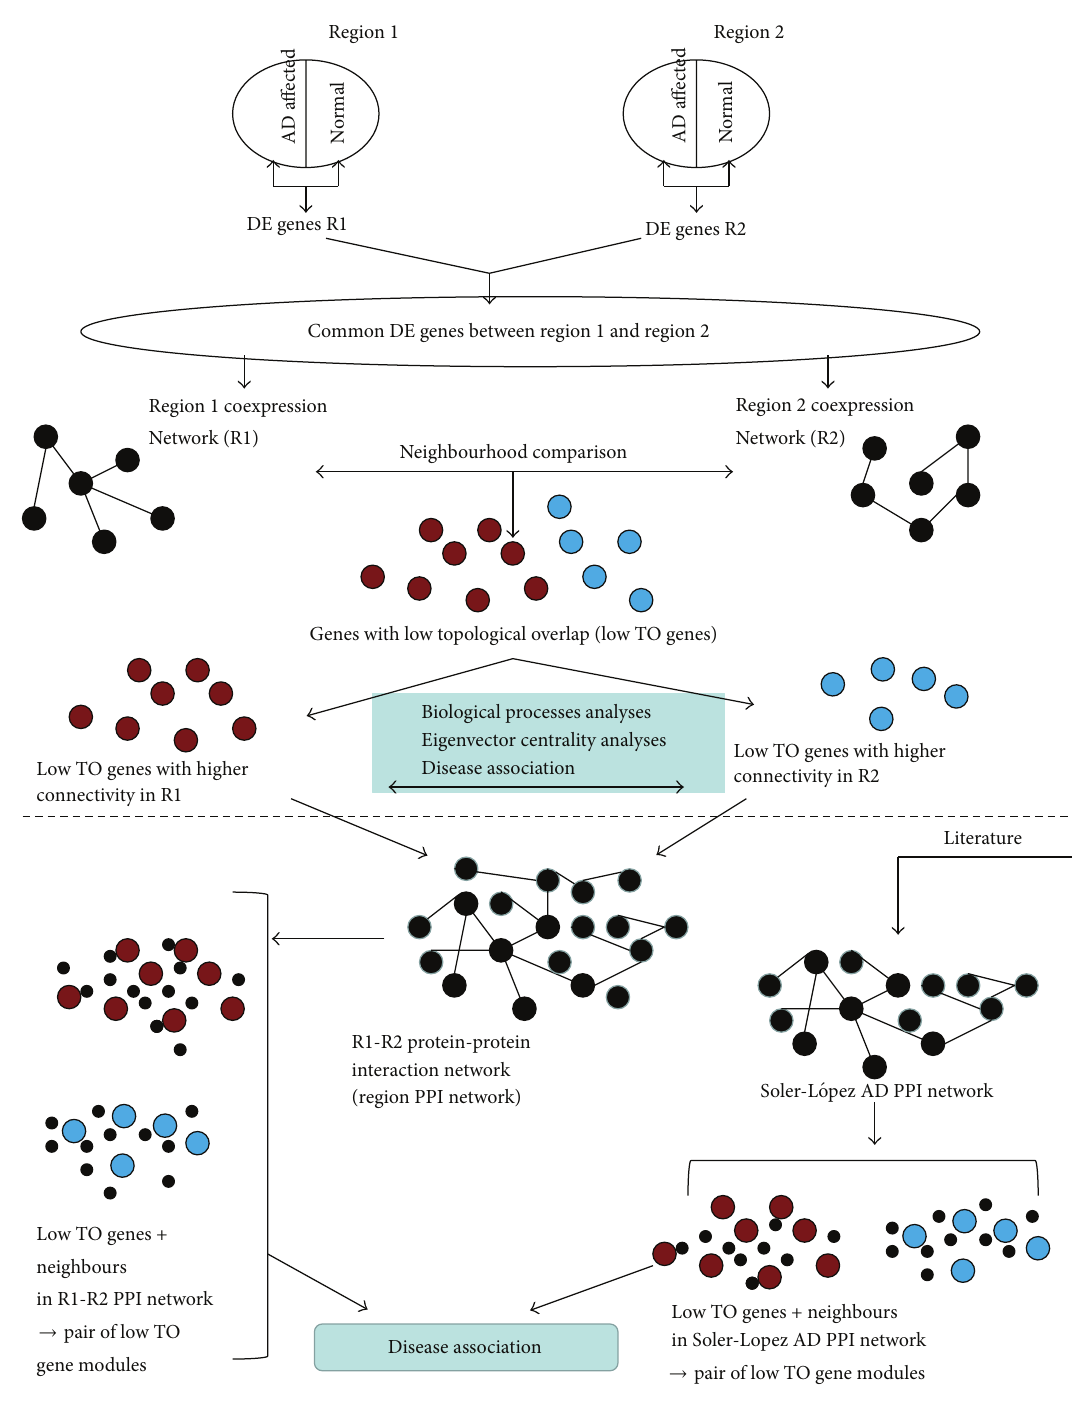
Figure 2: Analyses flowchart. The top half of the figure (above the dashed line) shows how the genes with low topological overlap (low TO genes) are selected and then analyzed for association with biological processes and diseases. The bottom half of the figure shows all the comparisons with the protein-protein interaction (PPI) networks. The region PPI network was created using our set of low TO genes as seed nodes. Since there were six regional comparisons, there resulted six region PPI networks. For each of the 6 regional comparisons, a pair of low TO gene modules was created. One low TO gene module contained the low TO genes that had a higher connectivity in a certain region (say R1) and their direct neighbors in the R1-R2 region PPI network and the other low TO gene module contained the low TO genes that had a higher connectivity in the other region (R2) and their direct neighbors in the R1-R2 region PPI network. The Soler-L´opez AD PPI network was reconstructed from the report by Soler-L´opez et al. The low TO genes from our analyses were mapped onto the Soler-L´opez AD PPI network for the creation of the pair of low TO gene modules. The creation of the pair of low TO gene modules was the same as before except that this time the neighbors were selected from the Soler-L´opez AD PPI